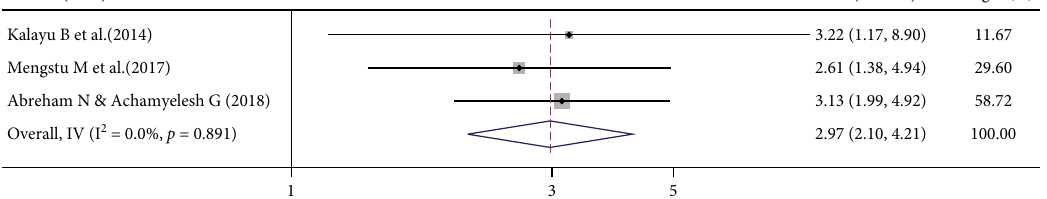
Figure 6: Forest plot for the pooled estimate of the e ff ect of follow-up appointment on Implanon discontinuation, a systematic review and meta-analysis, Ethiopia, 2022.